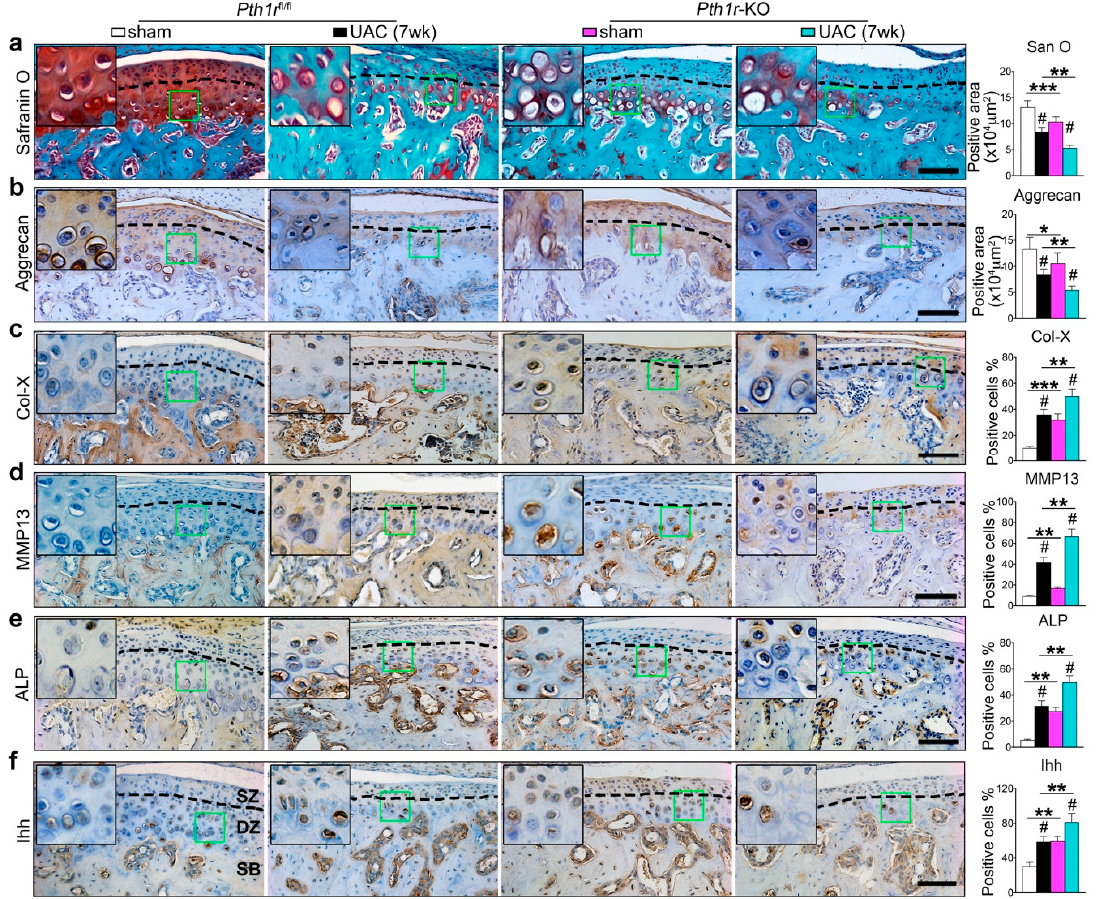
Figure 7. Pth1r knockout promoted the deep zone chondrocyte terminal differentiation. Cartilage-specific and tamoxifen-inducible Pth1r gene knockout ( Pth1r -KO) mice were exposed to 7 weeks of UAC treatment. The Pth1r fl / fl mice were used as the genetic control. ( a ) Safranin O staining and the quantitative data (right panel). ( b – f ) Immunohistochemical staining and the quantitative data (right panel) for aggrecan ( b ), Col-X ( c ), MMP-13 ( d ), ALP ( e ), and Ihh ( f ). The green box regions in the images were magnified at the top left corner. Black dotted lines distinguish the superficial and deep zone chondrocyte. SZ , superficial zone. DZ , deep zone. SB , subchondral bone. Magnification, 200 × . Scale bar, 100 µ m. n = 6. Results are represented as the mean ± SD. * p < 0.05, ** p < 0.01, *** p < 0.001 represent significant di ff erences between knockout group and genetic control group. # p < 0.05 represent significant di ff erences between the sham and UAC group in the Pth1r fl / fl and knockout groups.